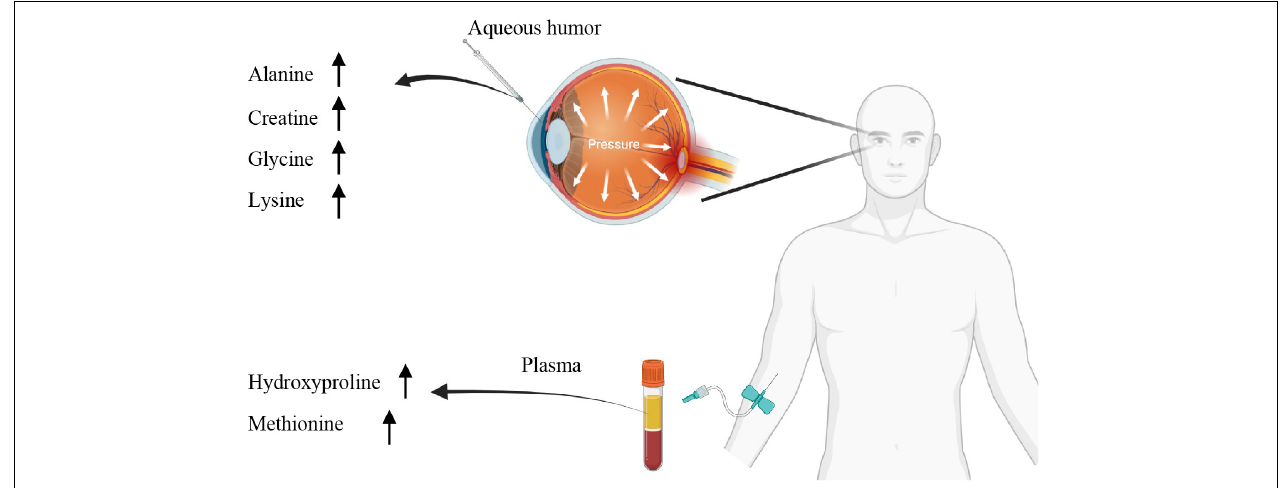
FIGURE 5 | Summary of the dysregulated